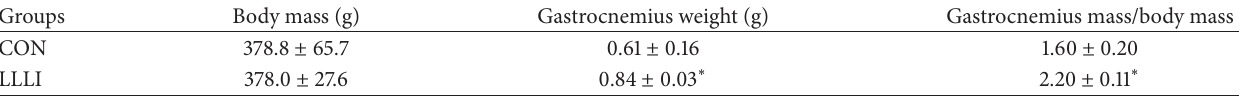
Table 2: Weight, gastrocnemius weight, and gastrocnemius mass/body